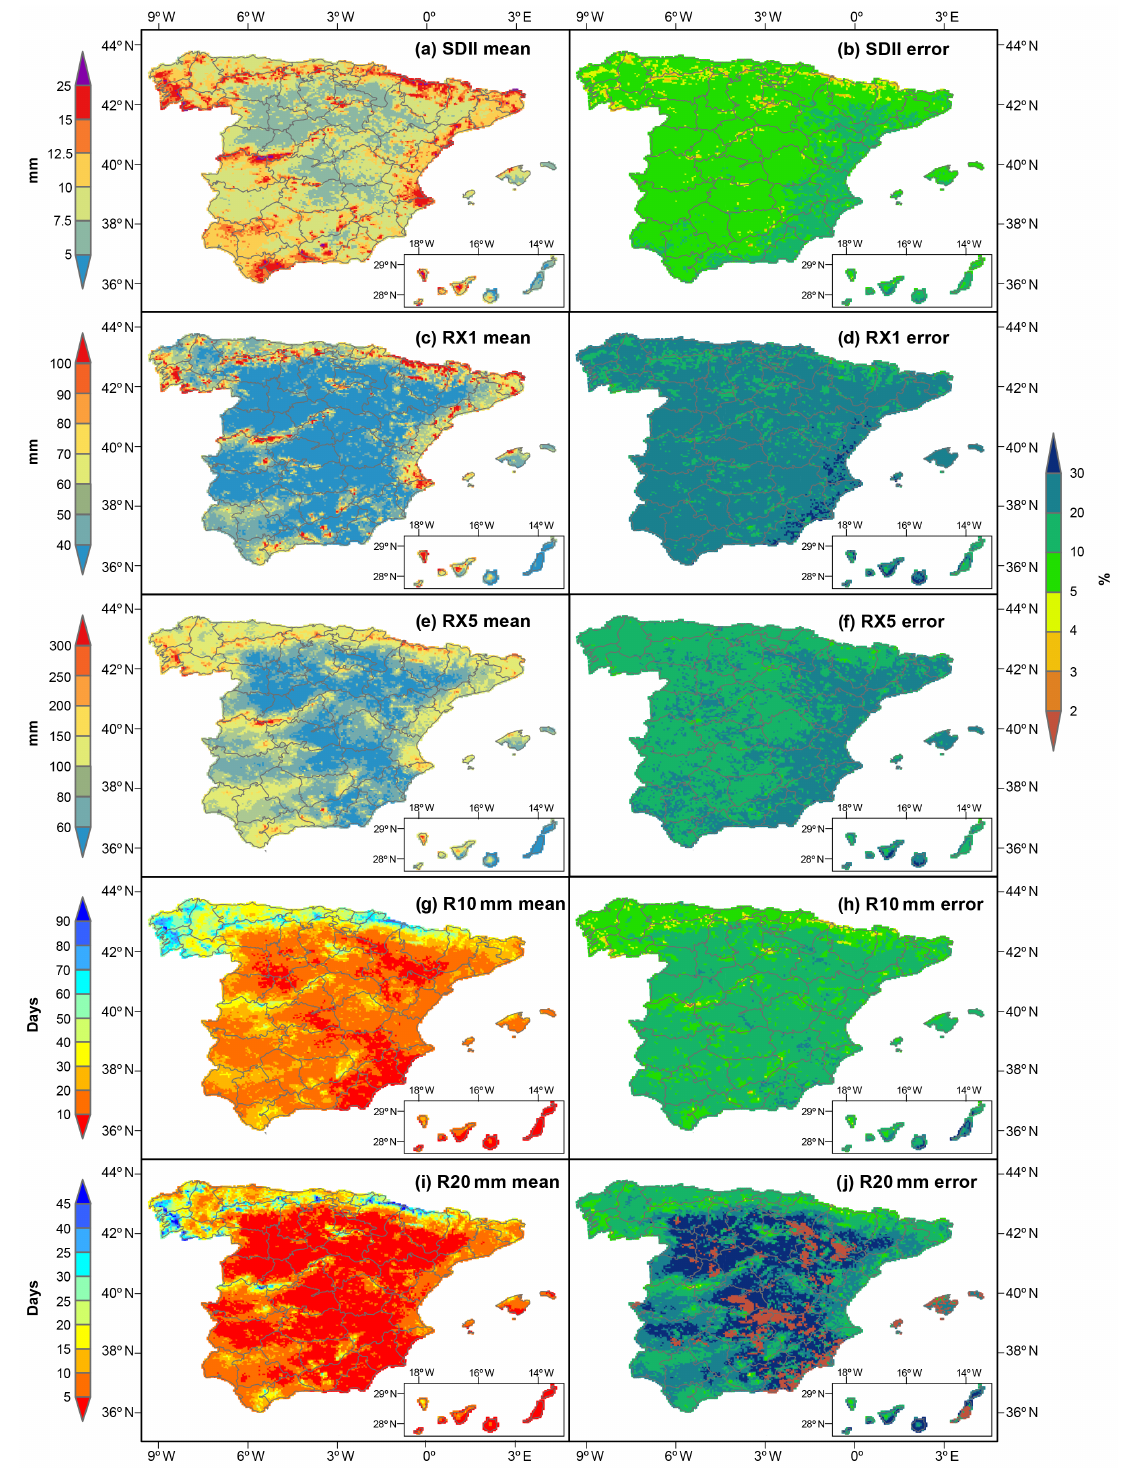
Figure 6. Daily extreme precipitation indices (a, c, e, g, i) and their uncertainty (b, d, f, h, j) . SDII: daily precipitation intensity; RX1: maximum 1-day precipitation; RX5: maximum 5-day precipitation; R10mm: number of days with precipitation over 10mm; R20mm: number of days with precipitation over